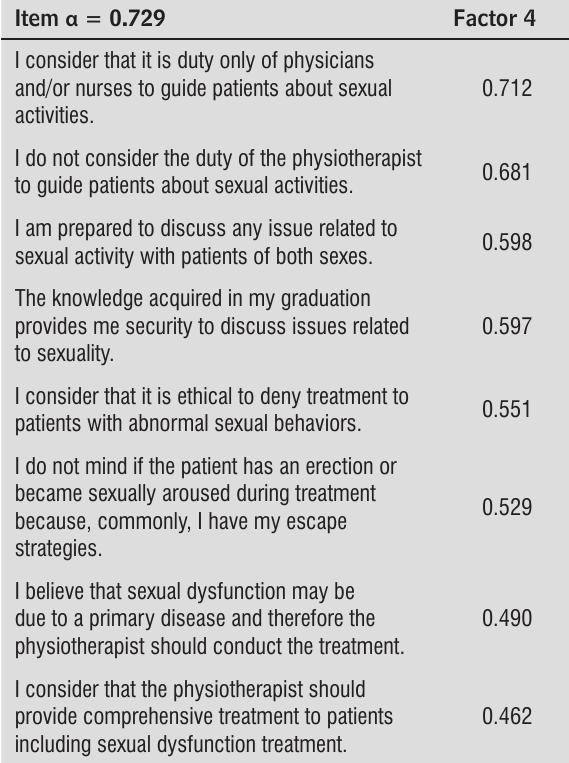
Table 4 - Factor analysis from the extraction of the attitude domain items